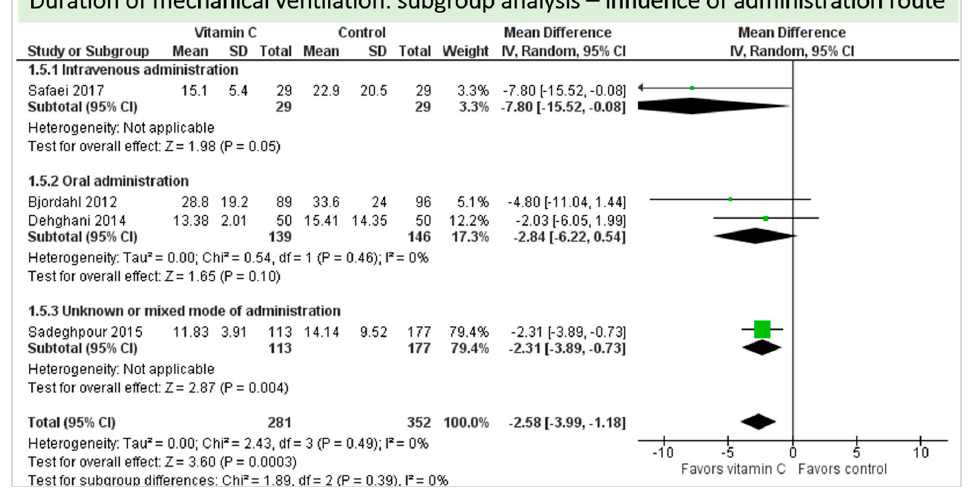
Figure 12. Duration of mechanical ventilation in hours: subgroup analysis—influence of administration route.